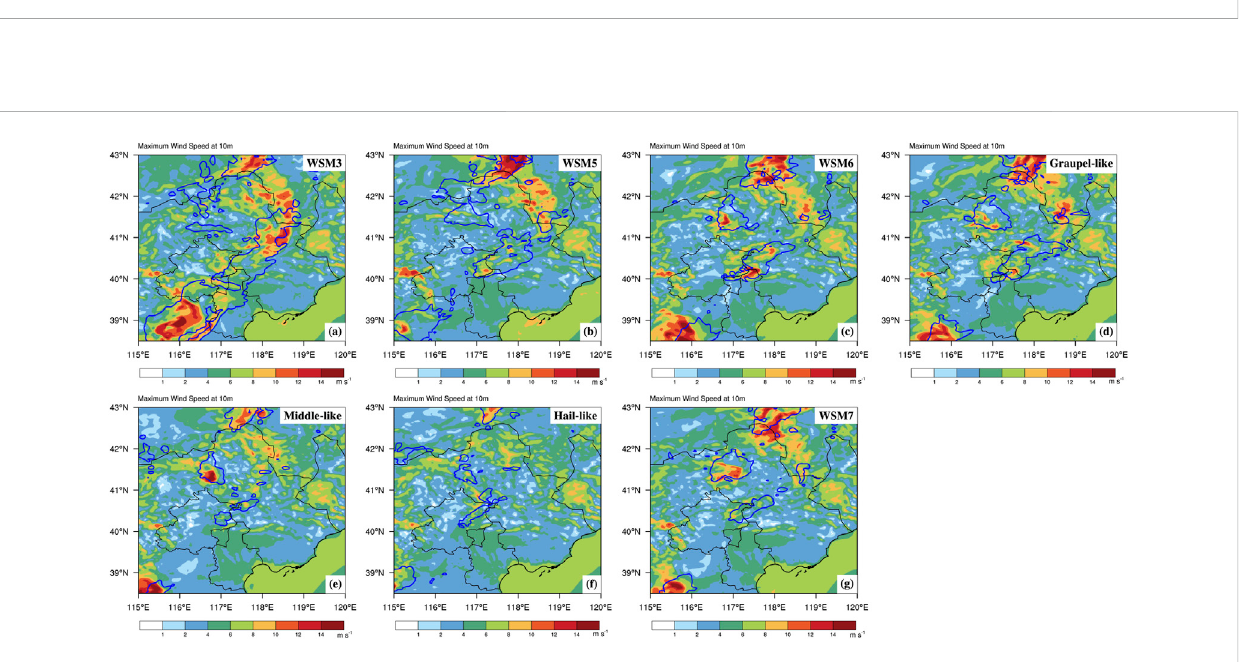
FIGURE 7 Simulated10-mwindmaximumspeed(shaded;ms − 1 )attimeofconvectivedevelopmentforallsevenexperiments: (A) WSM3, (B) WSM5, (C) WSM6, (D) WSM6-Graupel-Like, (E) WSM6-Middle-Like, (F) WSM6-Hail-Likeand (G) WSM7experiments.Thebluecontoursindicatesimulated15 dBZcomposite radar re fl